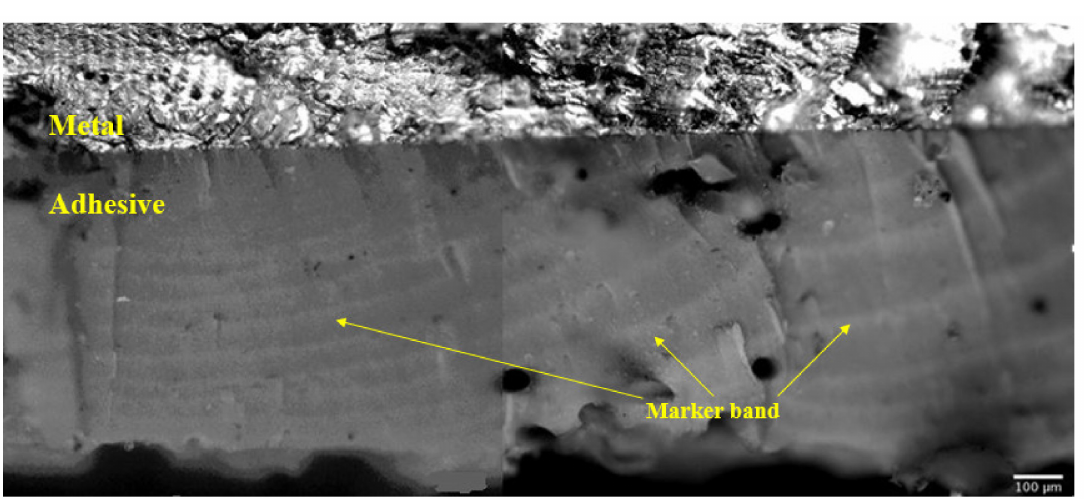
Figure 2. Illustration of (multiple) small crack growth in an adhesive in the tests discussed in [21], previously unpublished